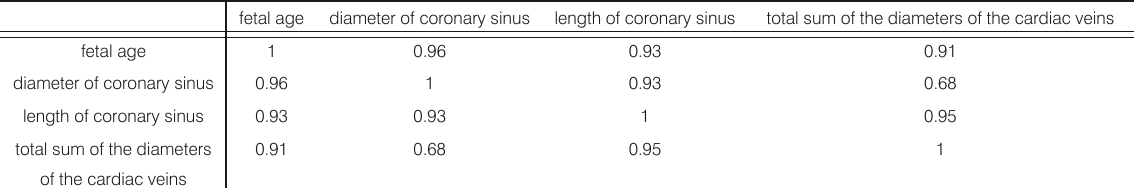
Table 7. The correlation matrix (r) between fetal age (x cardiac veins